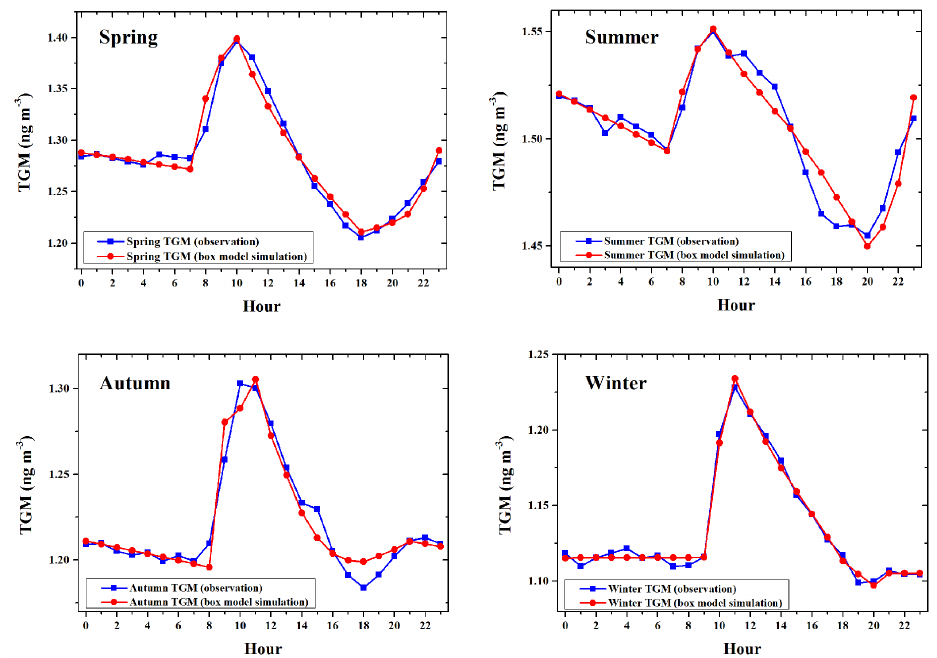
Figure 7. Diurnal profiles of average hourly TGM at Nam Co Station by season during the measurement period compared with the box model simulation.